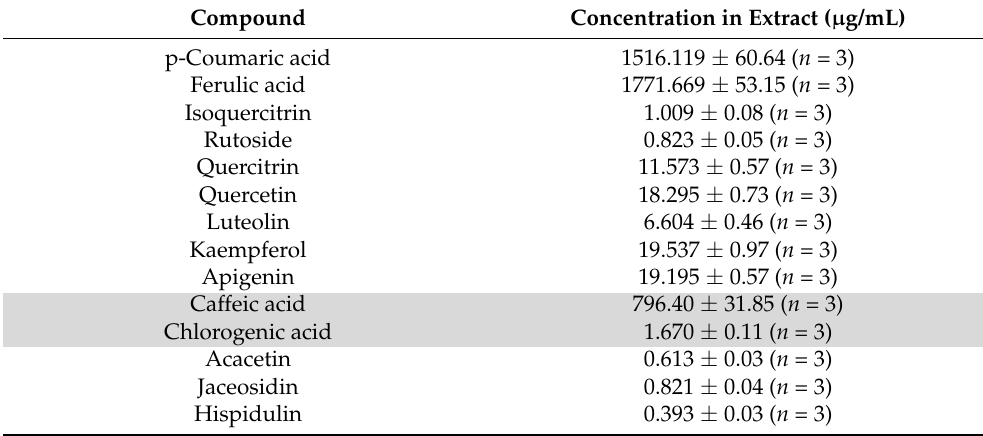
Table 1. Concentration of phenolic compounds ( µ g/mL) in the hydroalcoholic propolis extract.